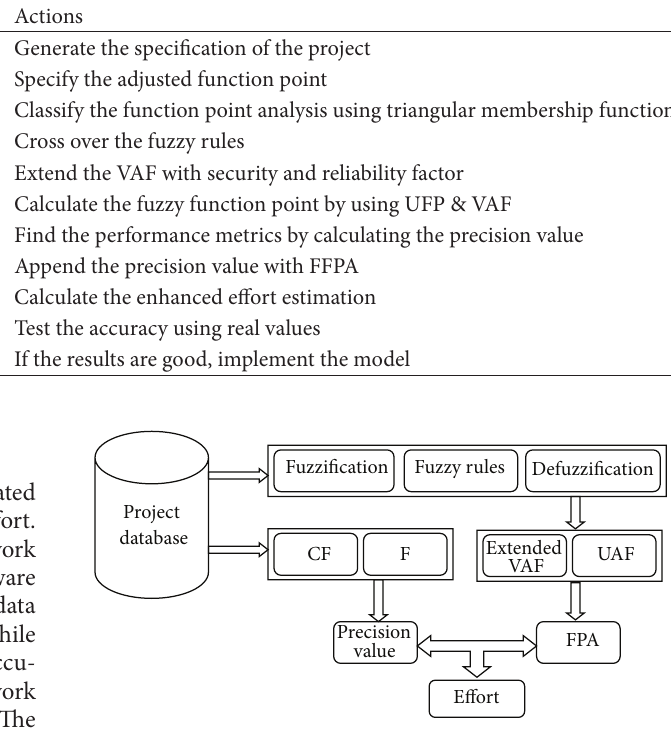
Figure 1: FFPA-PSR estimator tool